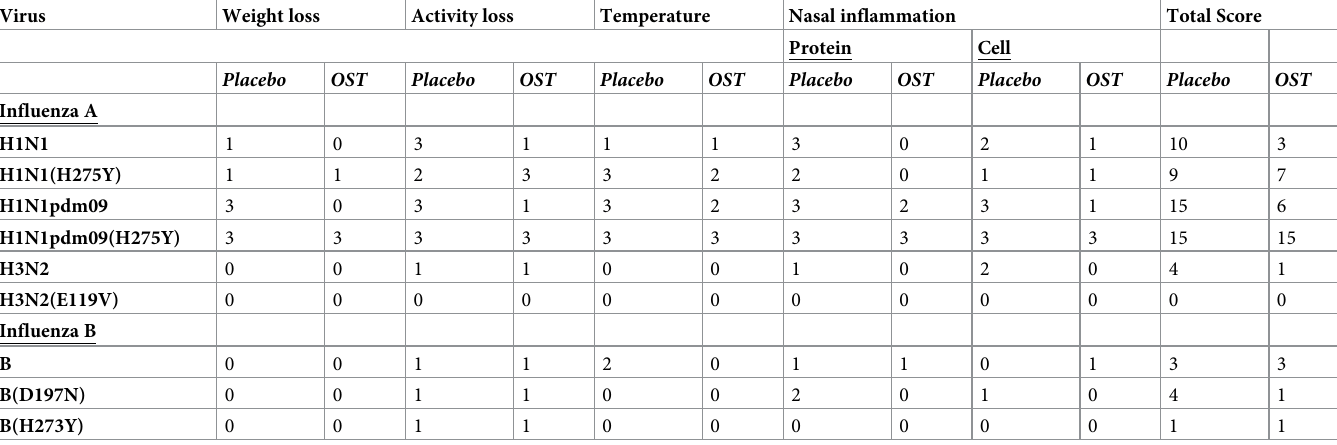
Table 3. Severity of clinical signs in ferrets infected with influenza